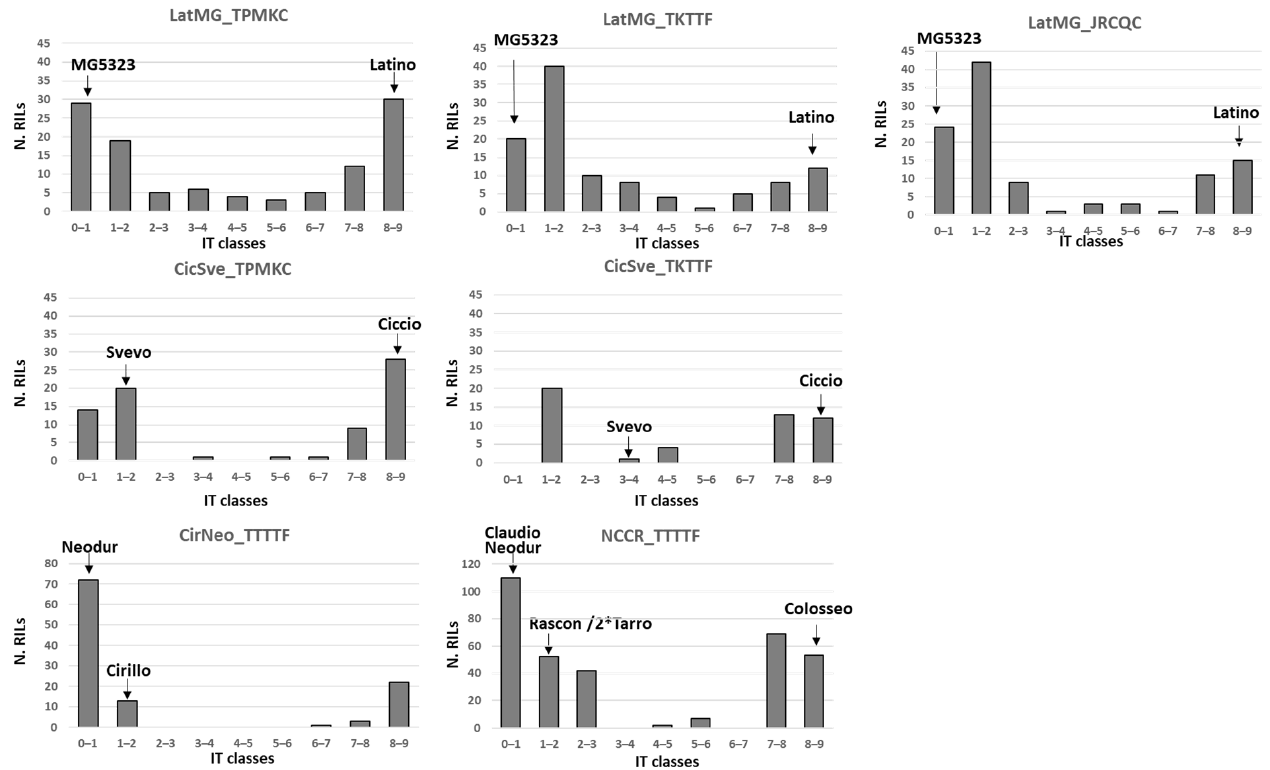
Figure 1. Frequency distribution of the ITs in the four segregating populations. The phenotypic class for each parent is indicated by the arrow. Table 1. Chi-square tests for segregation of stem rust reaction in four recombinant inbred line populations of durum